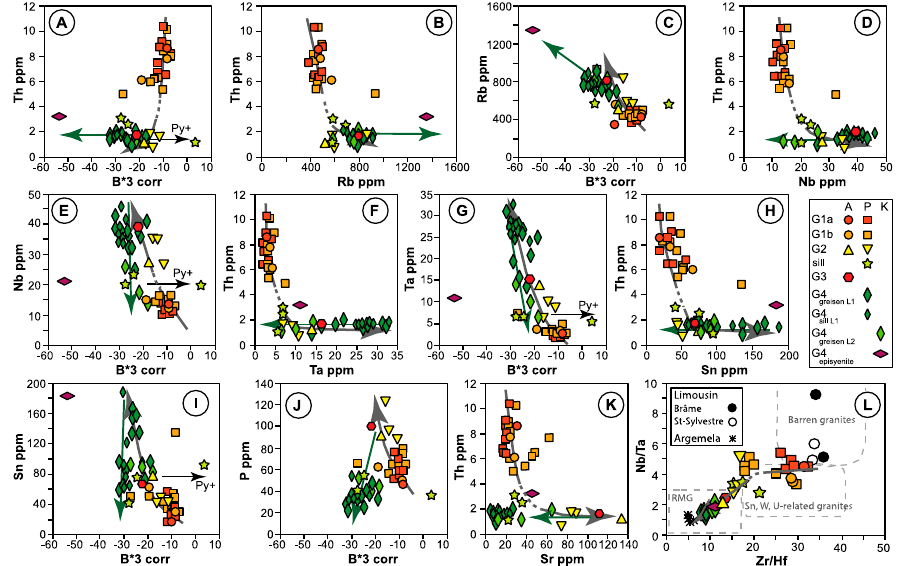
Figure 29. Disentangling magmatic and alteration trends in the Panasqueira suite using trace elements (Table S4). Trace element variations are potential markers of the magmatic fractionation: inert element Th, B*3 parameter (from the Q*3B*3F*3 diagram in Figure 25C), and Nb / Ta and Zr / Hf ratios. Estimated trends: grey arrow, magmatic fractionation trend, green arrow, a hydrothermal trend in the greisenised facies. ( A ) Th vs. B*3 diagram, demonstrating that it is e ff ectively possible to disentangle magmatic and alteration trends using these parameters. ( B , C ) Th vs. Rb (B) and Rb vs. B*3 (C) diagrams, showing that greisens are characterized by an increase in Rb contents beyond the values reached in the fractionation process. ( D , E ) Th vs. Nb (D) and Nb vs. B*3 (E) diagrams, demonstrating that greisens are characterized (F) and Ta vs. B*3 (G) diagrams, showing that Ta behaved as Nb in both fractionation and